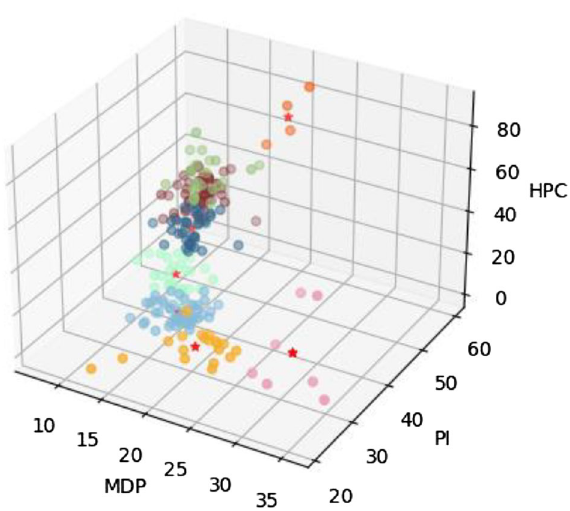
Figure 1. Unscaled (non-normalised) 3D scatterplot of the k -means cluster solution showing eight clusters. Red stars are cluster centroids (due to the 3D nature of the plot, not all cluster centroids can be seen in the plot). Colours correspond to Fig.